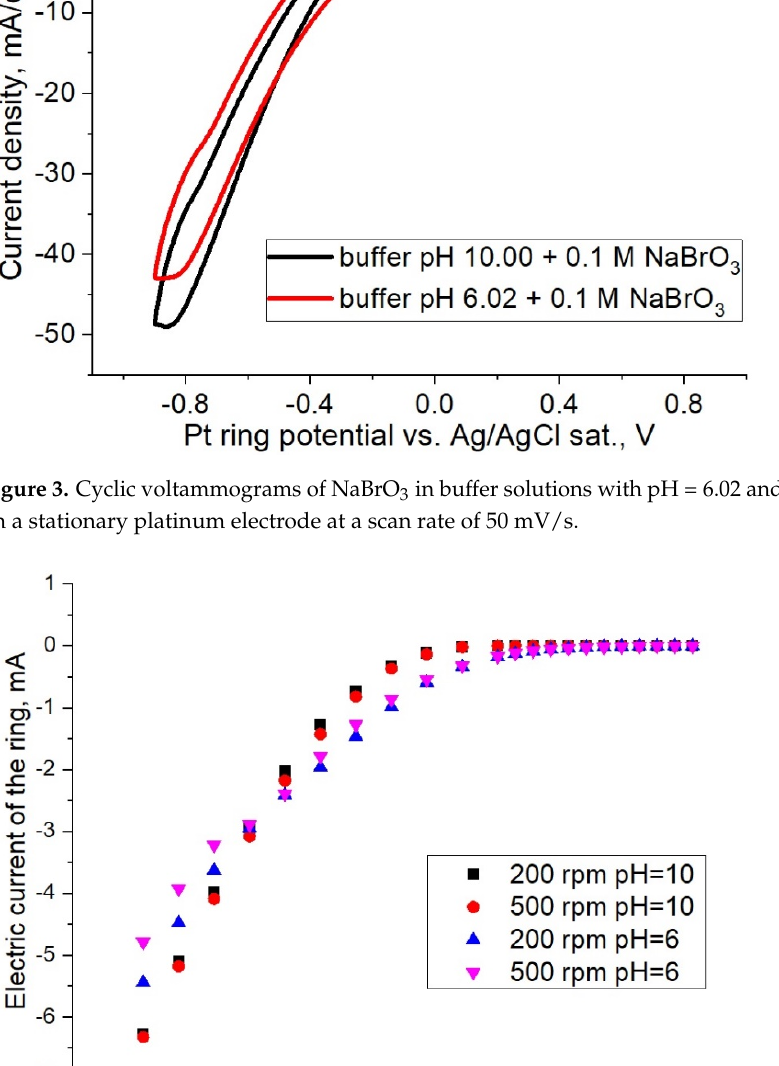
Figure 5. Cyclic voltammograms of 0.1 M OBr − recorded at 50 mV/s on the stationary platinum electrode. pH = 11.66.